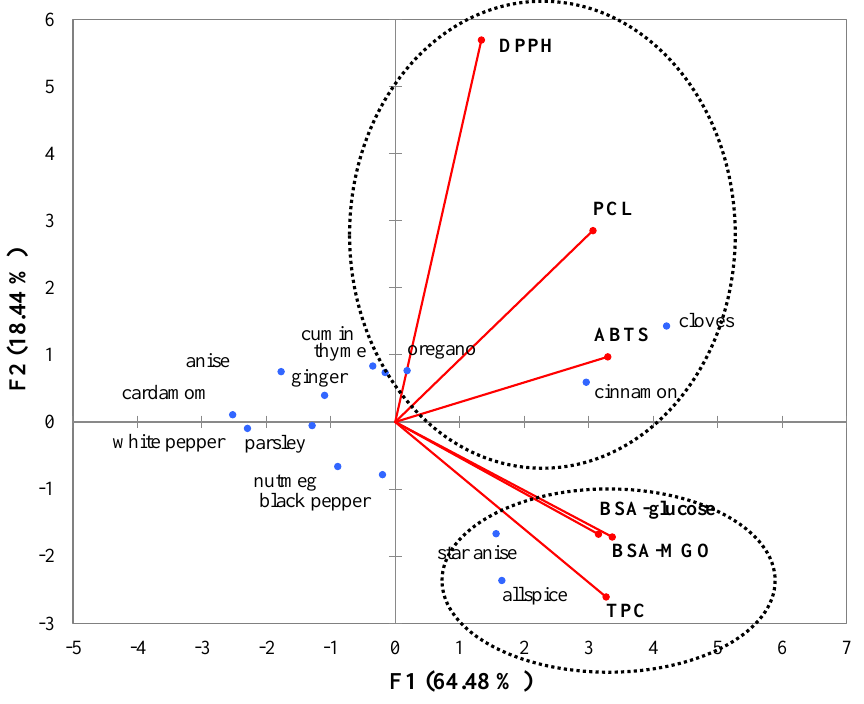
Figure 2. The score plots of analyzed spices.